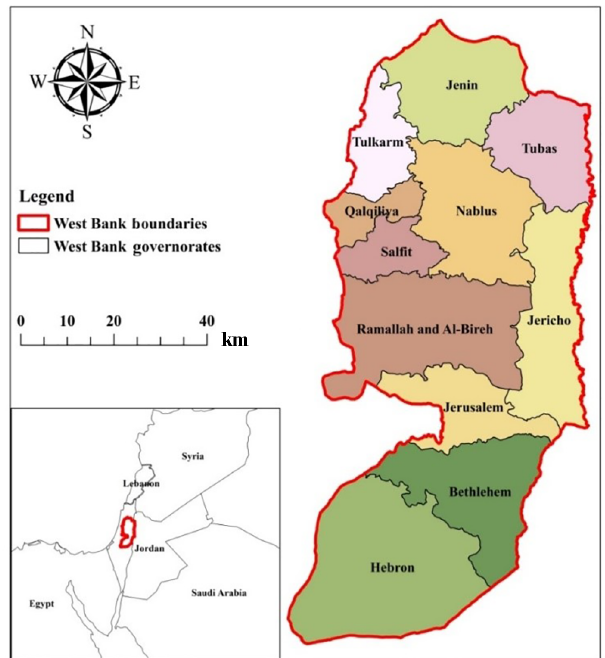
Figure 1. Regional setting of the West